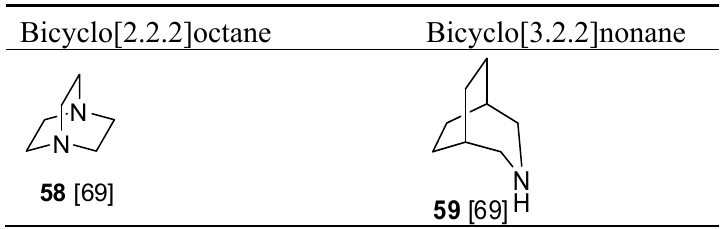
Table 8. Bicyclic amine monomers 58–59